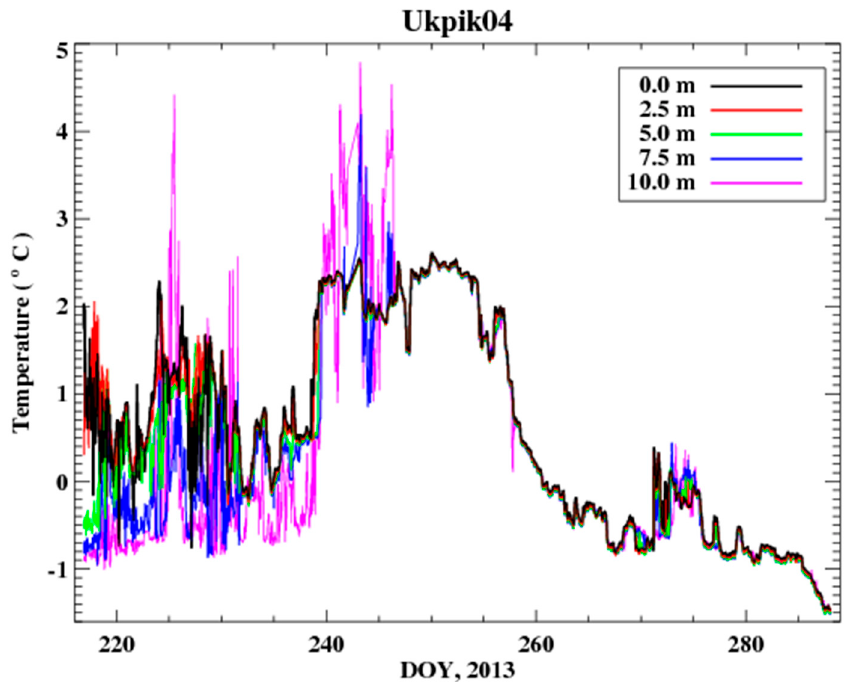
Figure 10. Temperatures in the top 10 m from the MIZOPEX UpTempO buoy (Ukpik04) deployed on 8 August 2013.